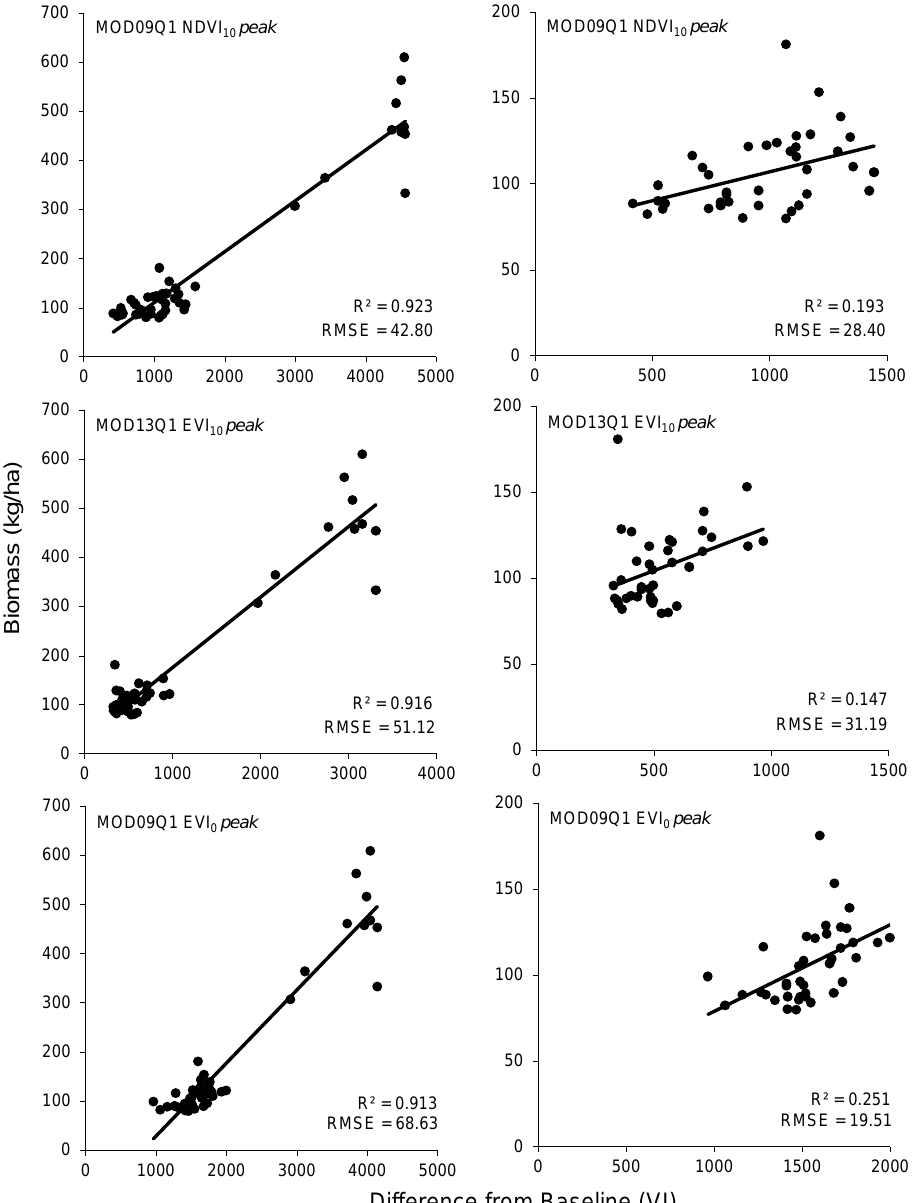
Of the MOD13Q1 data, the NDVI method after accounting for post-peak data collection provided the 10 best model (RMSE = 46.65), an improvement of 4.47 kg/ha (9.6%) over the next best model (Table 2). Of the MOD13Q1 models, models using NDVI data performed slightly better on average (3.28 kg/ha–5.1%) than those using EVI data.